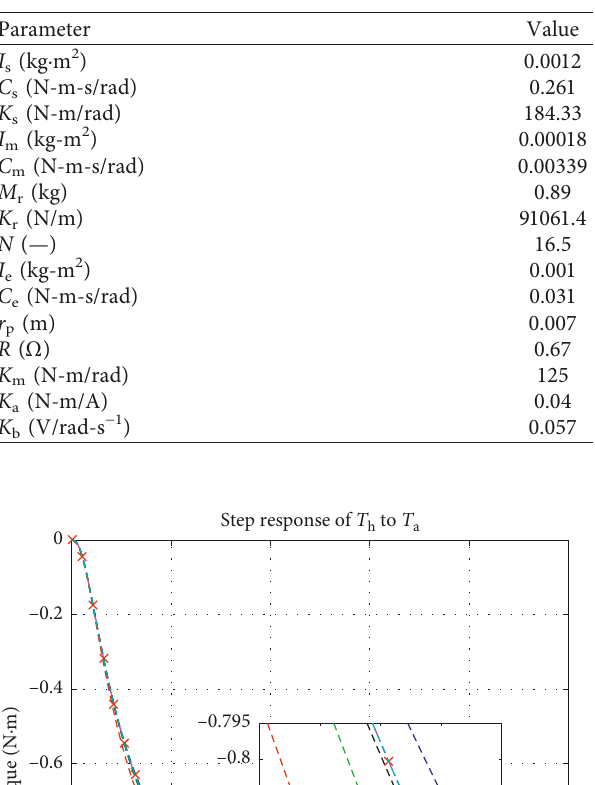
Figure 3: The design of fault-tolerant controller. Table 1: The parameters of EPS.